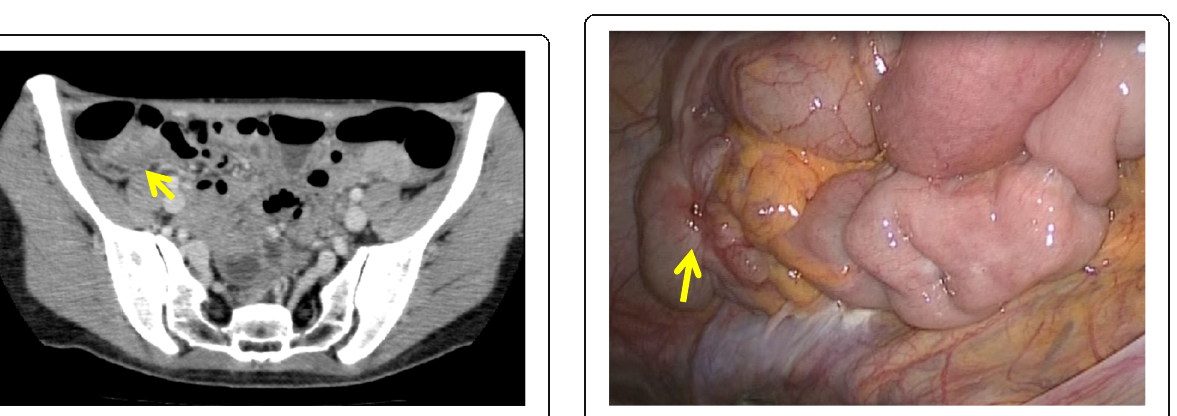
Fig. 1 On abdominal CT, an intensely stained mass with a 30-mm diameter, including a low-density region (arrow), was observed in the cecum